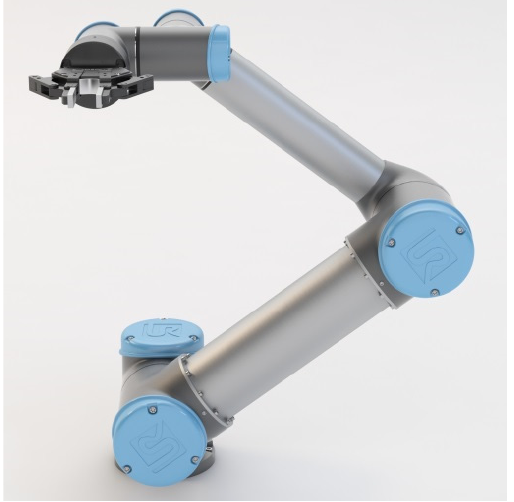
Figure 10. The UR5